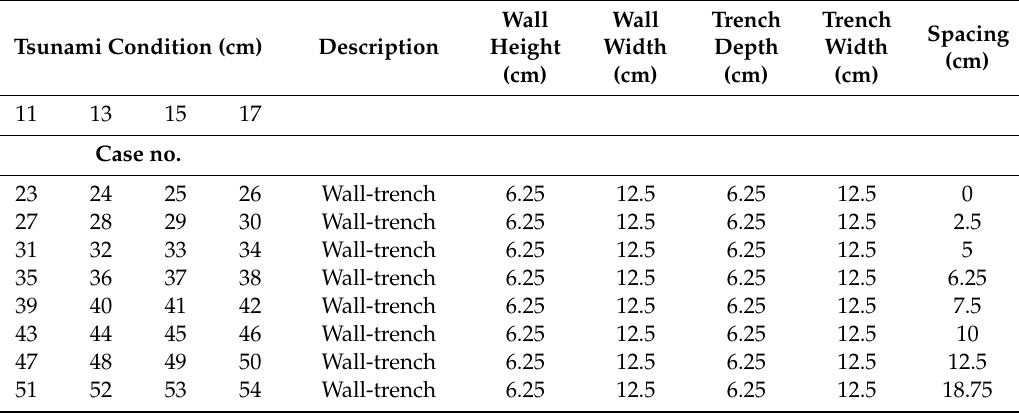
Table 4. Description of simulation cases with the details of onshore structures (in model scale).